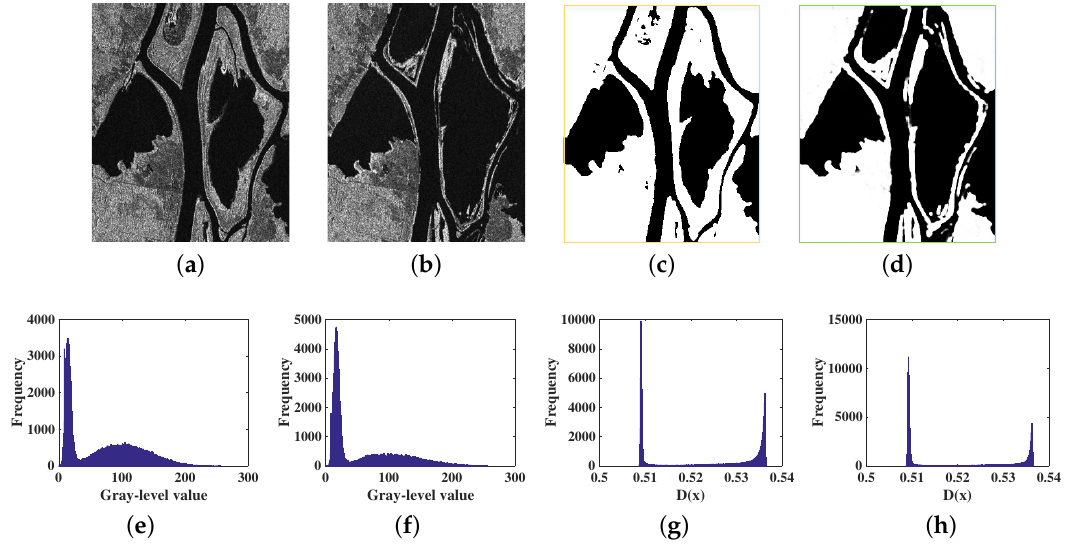
Figure 12. Comparison between original images and feature maps on Ottawa data set: ( a ) Original image I 1 , ( b ) Original image I 2 , ( c ) Feature map (estimated probability) F 1 , ( d ) Feature map (estimated probability) F 2 , ( e ) Real histogram of image I 1 , ( f ) Real histogram of image I 2 , ( g ) Real histogram of feature map F 1 , and ( h ) Real histogram of feature map F 2